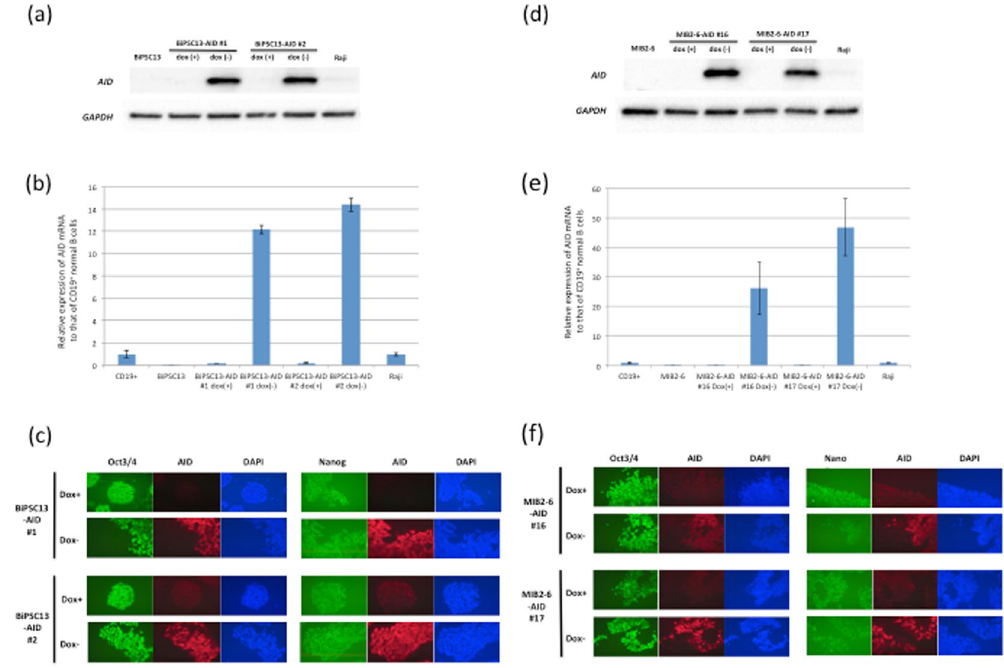
Figure 5. AID expression in BiPSCs induced with the doxycycline-controlled (Tet-off) system. ( a ) Induction of AID expression in the absence of doxycycline was confirmed in two clones (#1 and #2) derived from BiPSC13 by western blotting, and ( b ) qRT-PCR. In ( b ), the numbers on the Y axis are the relative ratio comparing the expression of AID mRNA of each sample standardized by the expression of GAPDH mRNA with that of CD19 + normal B cells purified from normal LN using CD19-microbeads. Raji, Burkitt lymphoma cell line. Data were analyzed in triplicates and normalized to glyceraldehyde 3-phosphate dehydrogenase. ( c ) Immunofluorescence analysis of the expression of Oct3/4 and Nanog in BiPSC13-AID (#1 and #2) after the induction of AID expression in the absence of doxycycline. ( d ) Induction of AID expression in the absence of doxycycline in two clones (#16 and #17) derived from MIB2-6 by western blotting, and ( e ) qRT-PCR as described in the legend to ( b ). ( f ) Immunofluorescence analysis of the expression of Oct3/4 and Nanog in MIB-AID (#16 and #17) after the induction of AID expression in the absence of